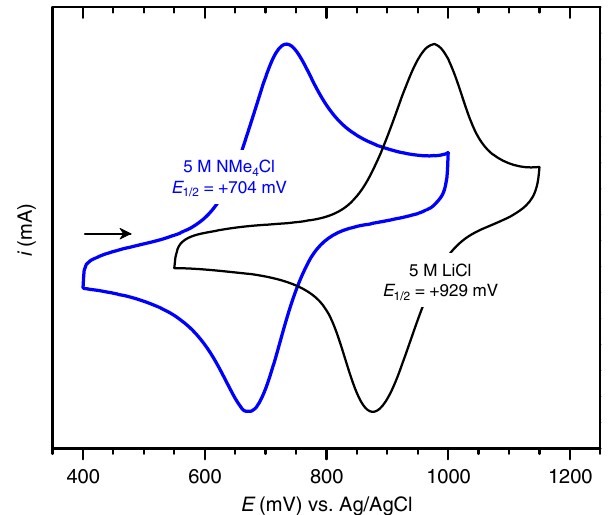
Fig. 1 Effect of Li + vs. [NMe 4 ] + on the Np VI /Np V couple. Current- normalized cyclic voltammetry data for solutions of 5 mM Np V dissolved in 5 M NMe 4 Cl or 5 M LiCl at pH ≈ 1.3. The arrow indicates the initial scan direction. Initial and cathodic switching potential = 400/550mV;